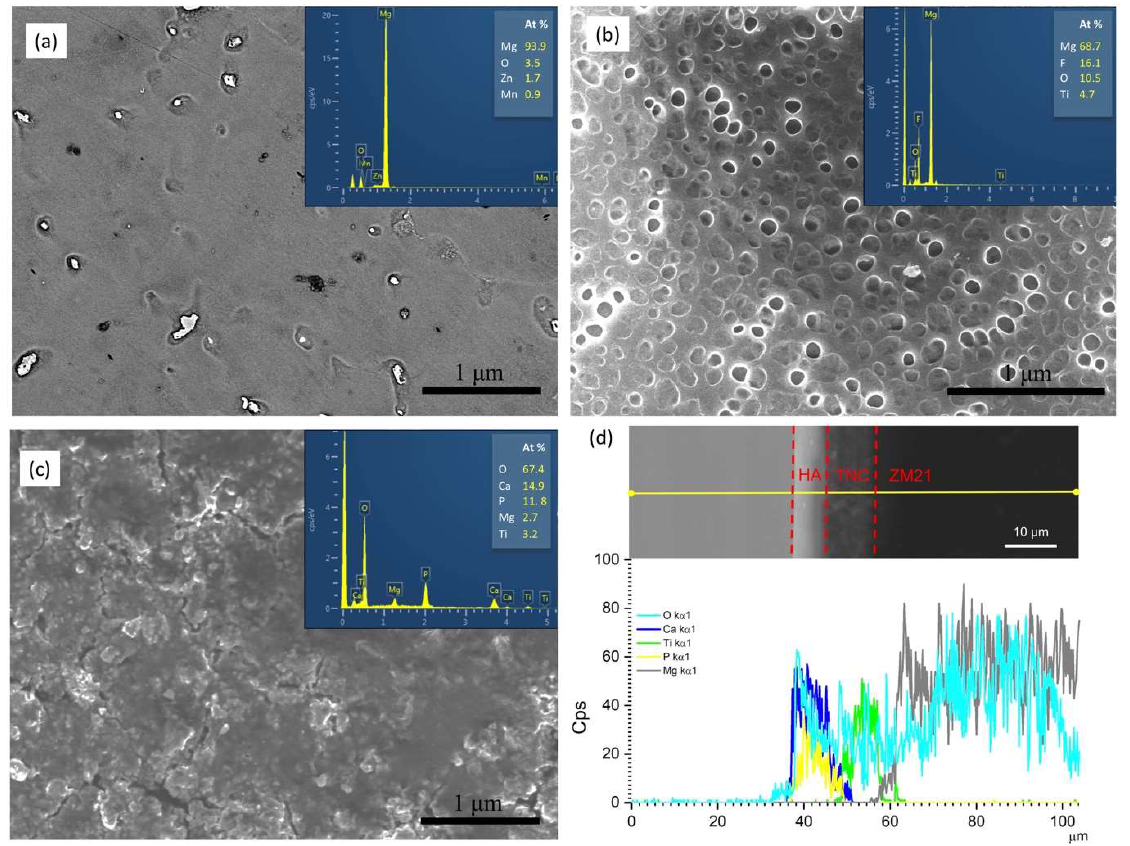
Figure 2. SEM-EDX analysis of: ( a ) polished ZM21, ( b ) TNC-coated ZM21, ( c ) HA-TNC-coated ZM21, and ( d ) cross-section of HA-TNC-coated ZM21.